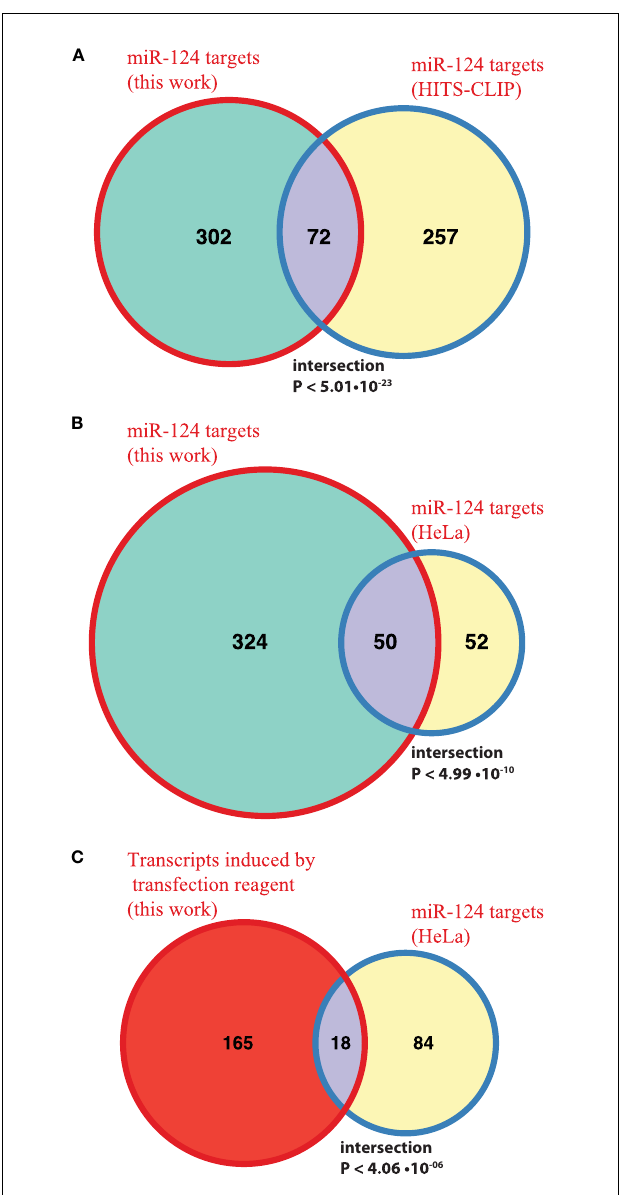
FIGURE 5 | Comparison with previously published miR-124 targets. (A,B) TheVenn diagrams show counts of putative direct targets of miR-124 that were inferred from the transfection experiments in this work and from the published HITS-CLIP sequencing (Chi et al., 2009) and microarray (Lim et al., 2005) experiments.The latter study is based on HeLa transfrection experiment.The mouse homologs of human miR-124 targets were retrieved from HomoloGene http://www.ncbi.nlm.nih.gov/homologene; (C) theVenn diagram shows counts of miR-124 targets reported in HeLa study (Lim et al., 2005) and transcripts induced by transfection alone in our experiment. In all cases the test universe was 3,465 mouse transcripts, with 3 (cid:48) UTRs containing one or more 7(2) or 7(1A)-type seed matching site for miR-124.The test universe was a complete list of mouse genes encoding transcripts with 3 (cid:48) UTRs containing one or more 7(2) or 7(1A)-type seed matching site for miR-124, and which were represented on Illumina Sentrix BeadChip Array Mouse-WG6 v2 microarray platform (3,465 genes in total).The text shows fold enrichment above what is expected by chance alone and the hypergeometric P -value for the